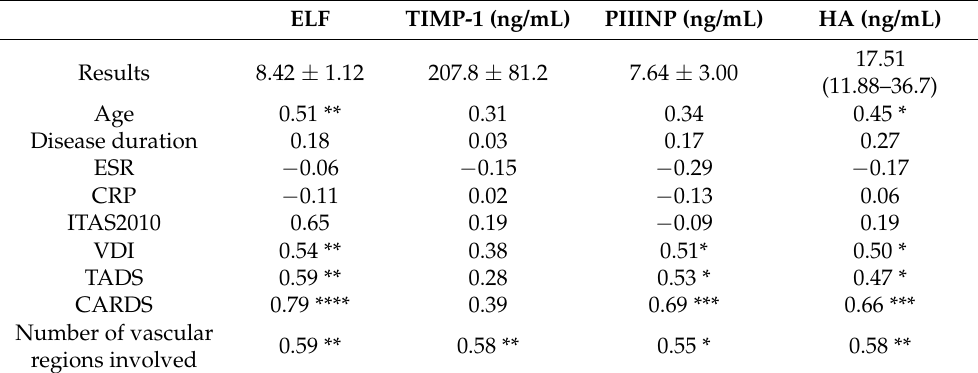
Table 4. Correlation coefficient (r) between ELF, TIMP-1, PIIINP, HA and clinical characteristics, damage and activity